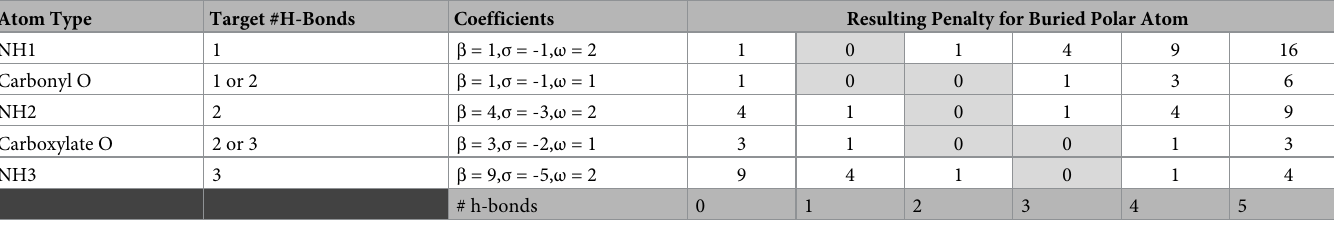
Table 1. Example penalty schemes for different atom